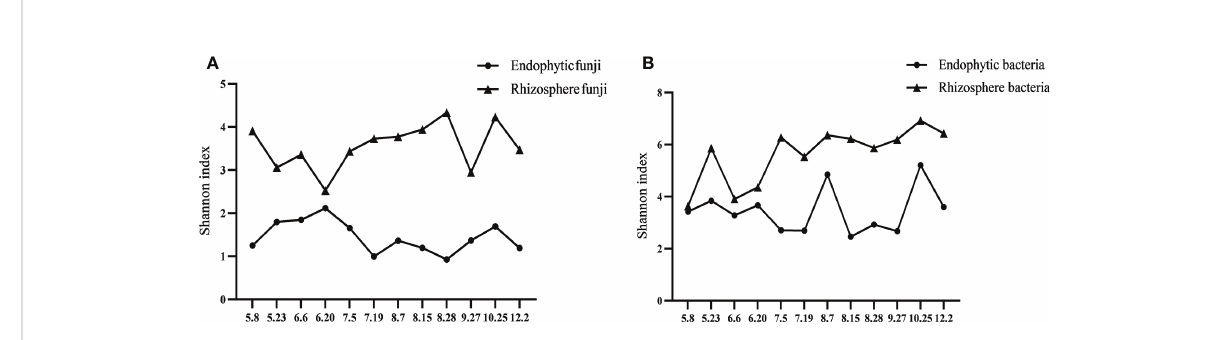
FIGURE 2 Shannon index line chart of Qianhu in the whole growth stage. (A) Fungi and (B) Bacterial.